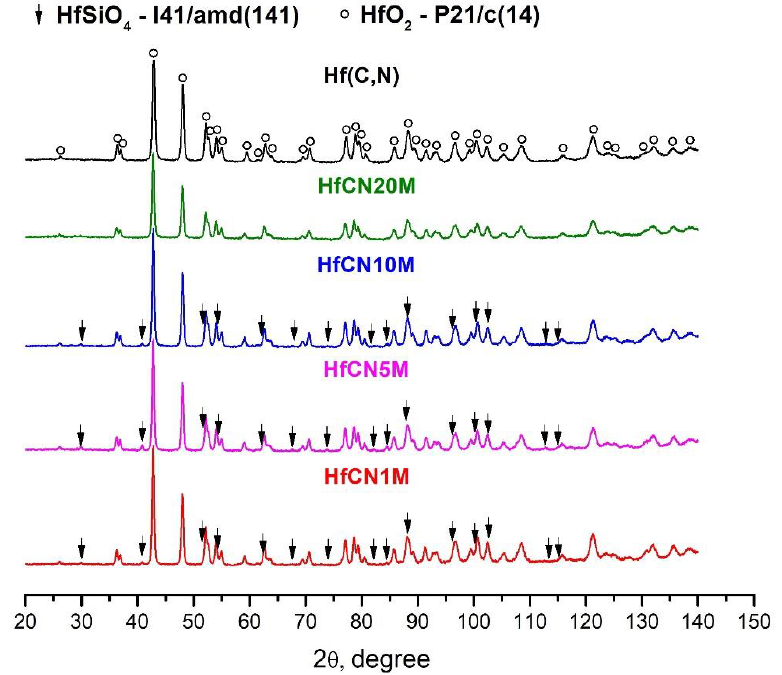
Figure 8. XRD data of the samples after oxidation in a furnace at 1000 °C.